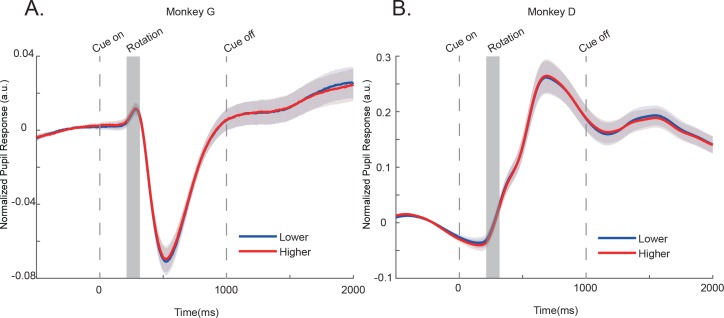
The pupil responses did not reflect the value of the perturbed cue.The sessions in which value-encoding neurons were recorded are plotted. Time 0 indicates the onset of cues. The blue and red curves are pupil responses when the lower and the higher value cue was rotated. The shading region around the curves represents the s.e.m between sessions. There was no significant difference between the two curves in either monkey.